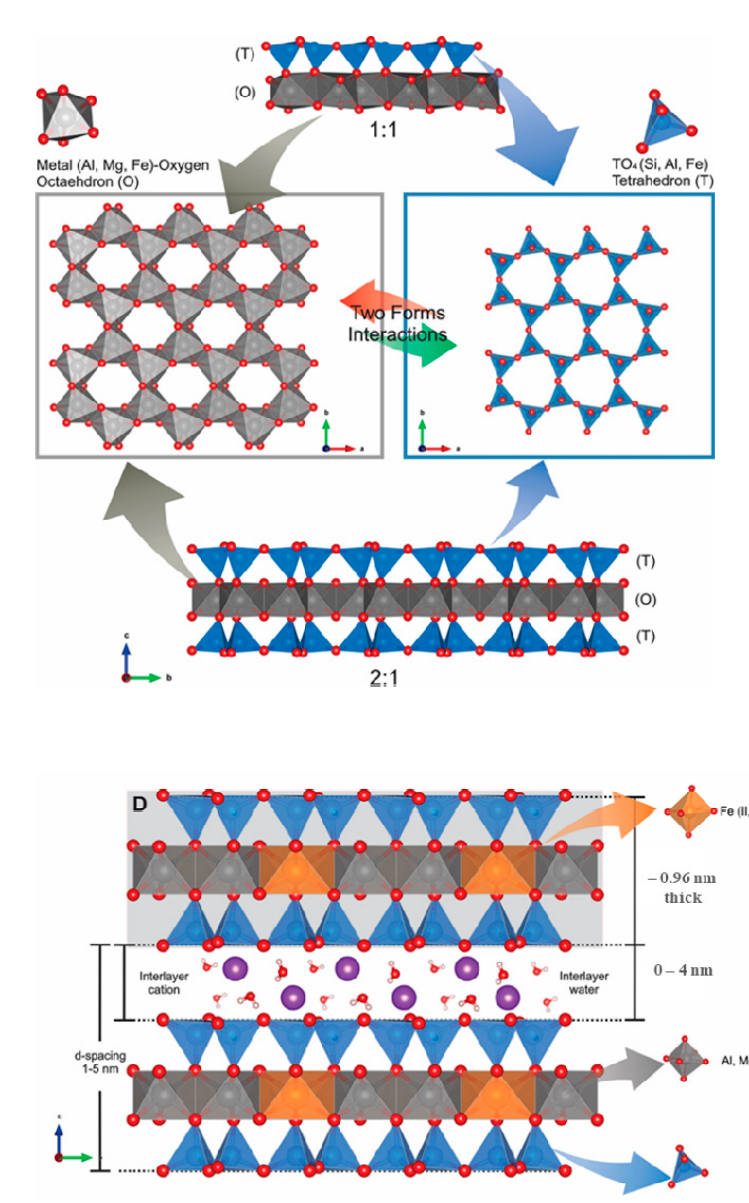
Figure 3. ( a ) Representative models of tetrahedral and octahedral sheets forming the 1:1 (TO) and 2:1 (TOT) layer structures and ( b ) 2:1 layer with hydrated interlayer cations. Different clay minerals have different structures and physicochemical properties.